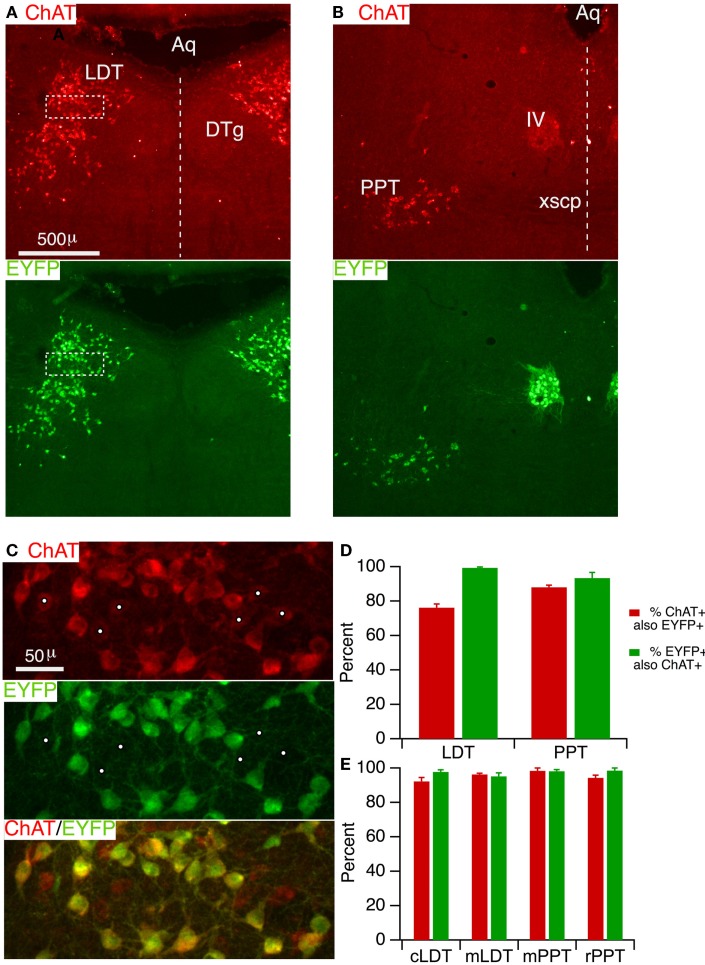
ChAT-Cre mice accurately drive reporter fluorescence in LDT and PPT cholinergic neurons. (A) Section through the LDT visualized with ChAT immunofluorescence (Alexa 594; top) and EYFP immunofluorescence (Alexa 488; bottom). (B) Section through the PPT visualized with ChAT immunofluorescence (Alexa 594; top) and EYFP immunofluorescence (Alexa 488; bottom). (C) Higher magnification of the boxed counting region in (A), visualizing label for ChAT (top), EYFP (middle), and both (bottom). The vast majority of ChAT+ neurons was EYFP+. White dots mark faintly labeled ChAT+ neurons, which appeared to lack EYFP. (D) Quantifies the efficacy (red) and specificity (green) of YFP reporter fluorescence in labeled cholinergic LDT and PPT neurons (n = 5 mice). Efficacy is indicated by the percent of ChAT+ neurons that were also immunopositive for EYFP. Specificity is indicated by the percent of EYFP+ neurons that are also ChAT+. (E) Similar quantification of ChAT-Cre expression using a ChR2-EYFP reporter line (n = 3 mice). Cells were counted in a field from the caudal LDT (cLDT), middle LDT (mLDT), middle PPT (mPPT), and the rostral PPT (rPPT). Dotted line indicates the midline. Aq, cerebral aqueduct; LDT, laterodorsal tegmental nucleus; DTg, dorsal tegmental nucleus; PPT, pedunculopontine tegmental nucleus; IV, trochlear nucleus; xscp, decussation of the superior cerebellar peduncle.